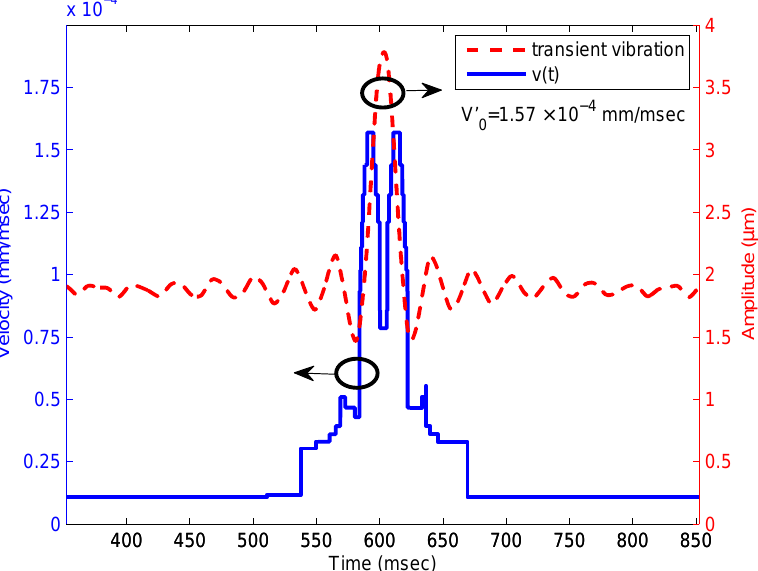
Figure 5. Experimental results. Velocity profile of the transient pulse determined using wavelets (blue) and time-dependent signal applied to the target (red). Circles indicate the axis for each